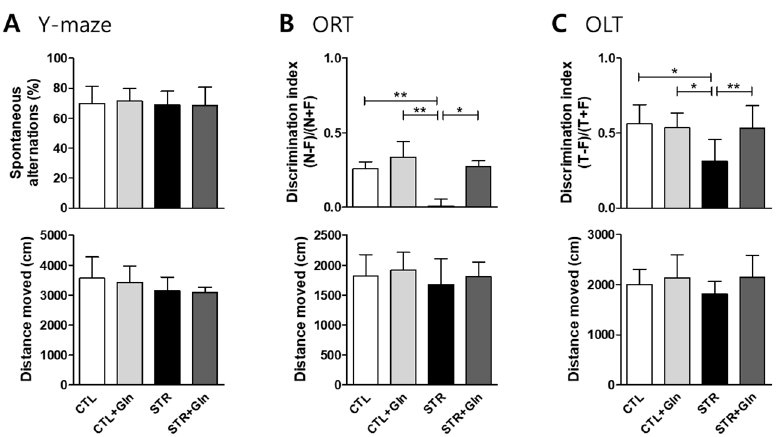
Figure 2. The harmful effects of chronic immobilization stress (CIS) on learning and memory are blocked by glutamine (Gln) supplementation. Short-term working memory was evaluated in mice using spontaneous alternations in a Y-maze ( A ), and learning and memory was evaluated using an object recognition test ( B ; ORT) and an object location memory test ( C ; OLT). The bar charts represent means ± SDs. * p < 0.05, ** p < 0.01, and *** p < 0.001 values in a one-way analysis of variance followed by Newman–Keuls multiple-comparison tests ( n = 7 / group, A – C ). CTL, control; CTL + Gln,